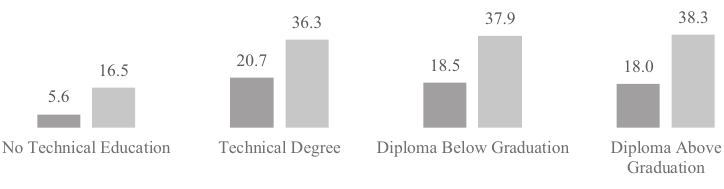
Figure 4. Distribution of